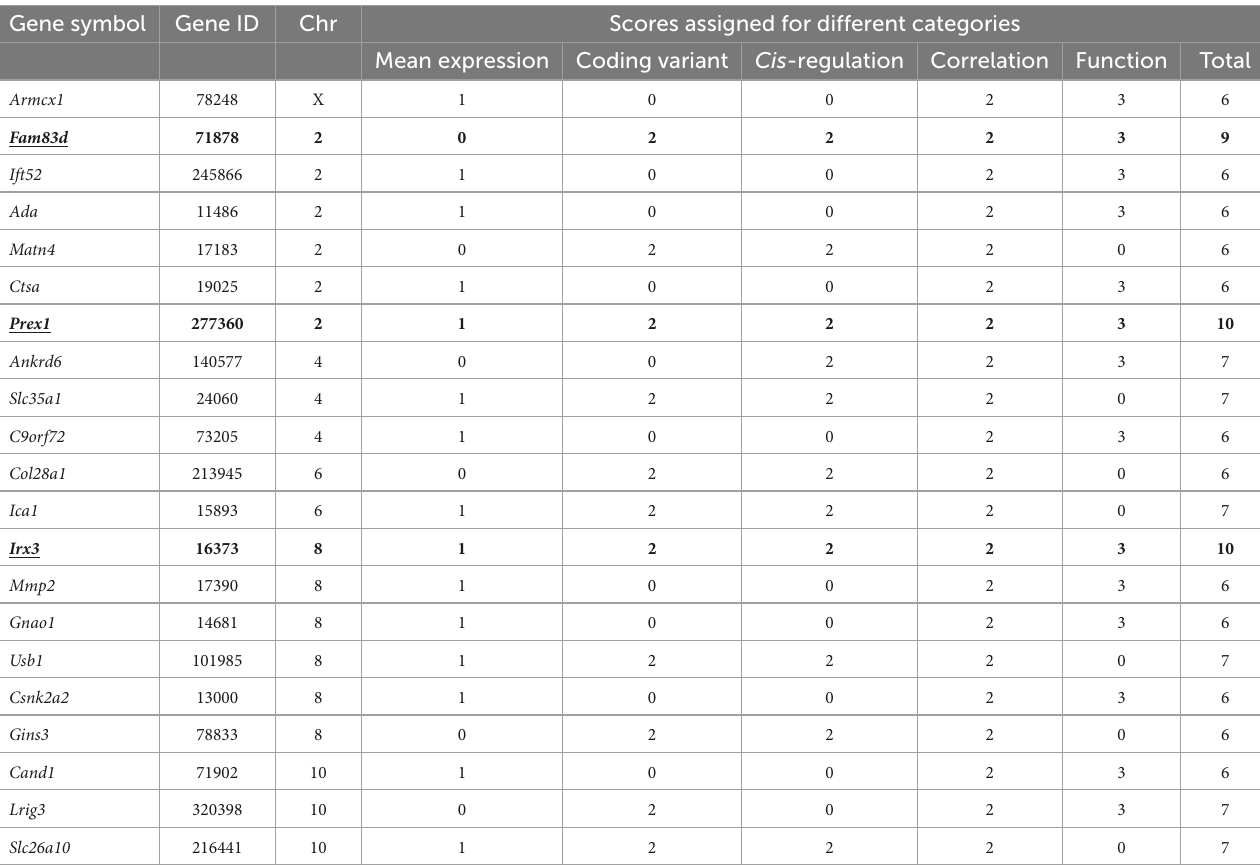
TABLE 1 Candidate genes associated with cardiac Cu phenotype identified in significant and suggestive